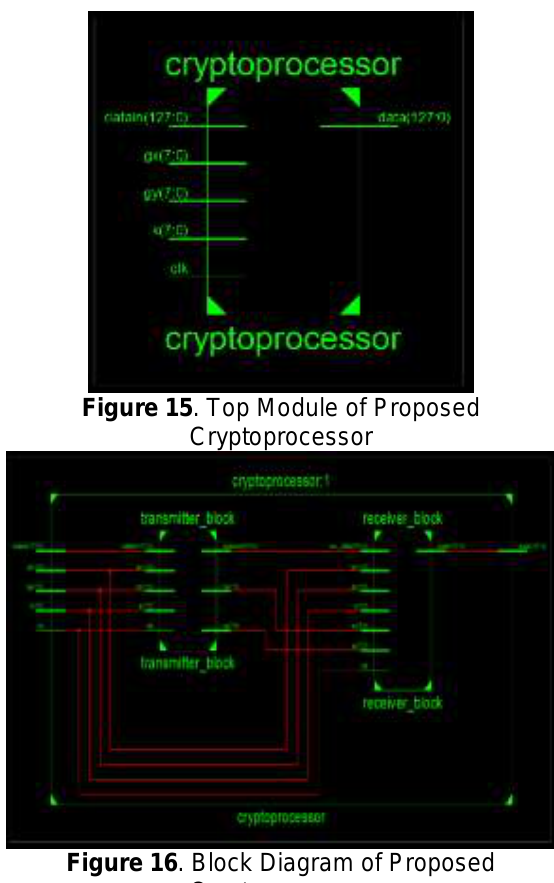
Figure 16 . Block Diagram of Proposed